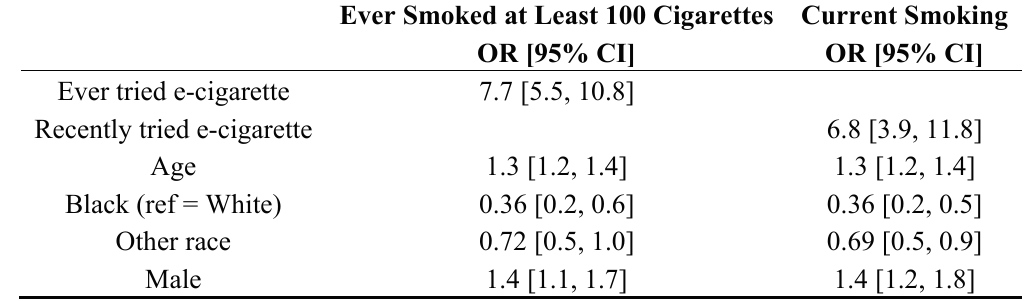
Table 1. Partial replication of main Dutra-Glantz result: Association of smoking and e-cigarette trialing.